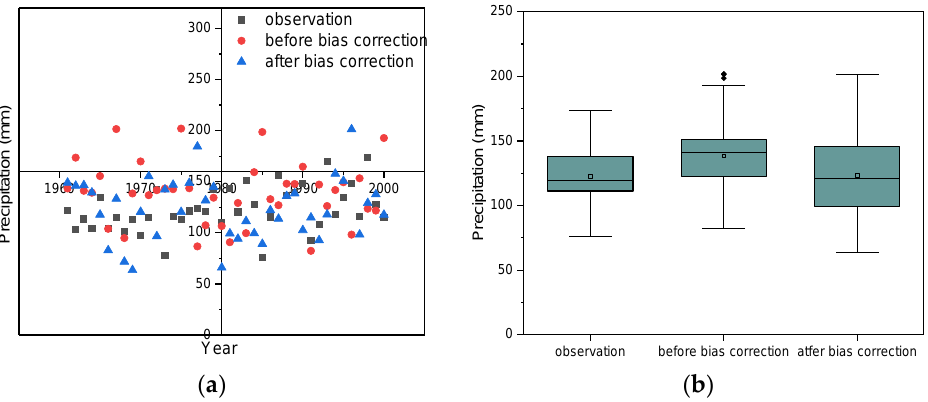
Figure 4. Extreme precipitation events before and after bias correction and historical observations. (a) is a scatter plot, and (b) is a box plot.